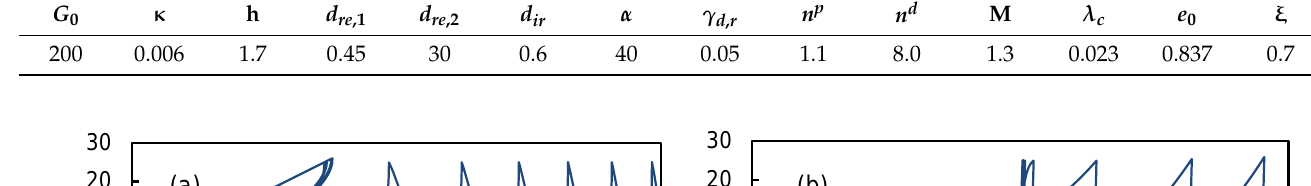
Table 2. Constitutive model parameter values used in this study.